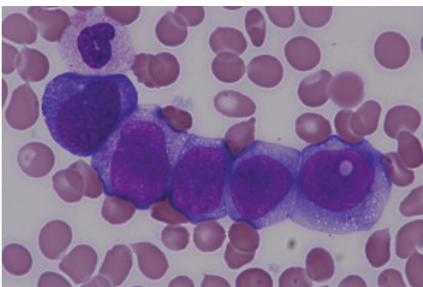
Figure 1: Peripheral blood slide review.